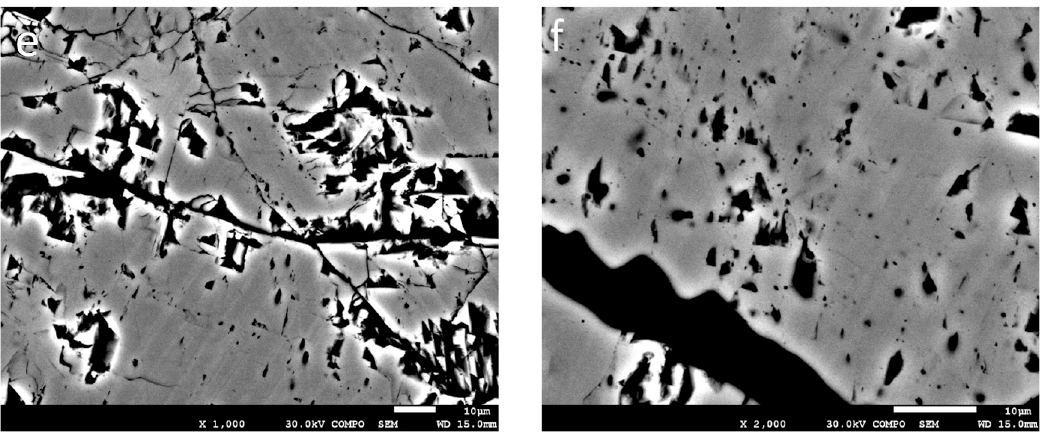
Figure 8. HD-SEM images of sample CY3068-C3, where the end members at 11,112 eV have been found. The images show no included minerals. ( a – d ) SEM images of area of 11,112 eV end members and ( e , f ) SEM images of fractured zones near the area where the peak at 11,112 eV was measured. The bright white point on the top-left image is an artefact due to metallization and the white edges on the bottom images are the contribution of topographical effects. The images at the top and middle left present zoning with dark and light bands. As analyses by LA-ICP-MS revealed no significant variation in composition, this is interpreted as a structural artefact. BSE images using an FEG-SEM showed no visible inclusion, regardless of the position or size of the area. The FEG-SEM was equipped with WDS that could not detect any Ge in these samples. Detection limits are expected to be comparable to